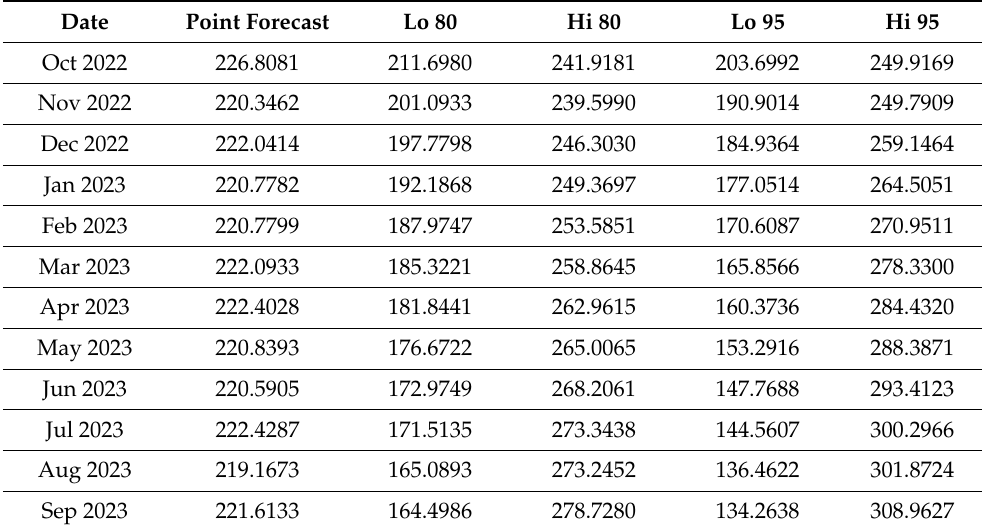
Table A1. Prediction of the development of coffee price in the commodity exchange ICE Futures US. Own processing.